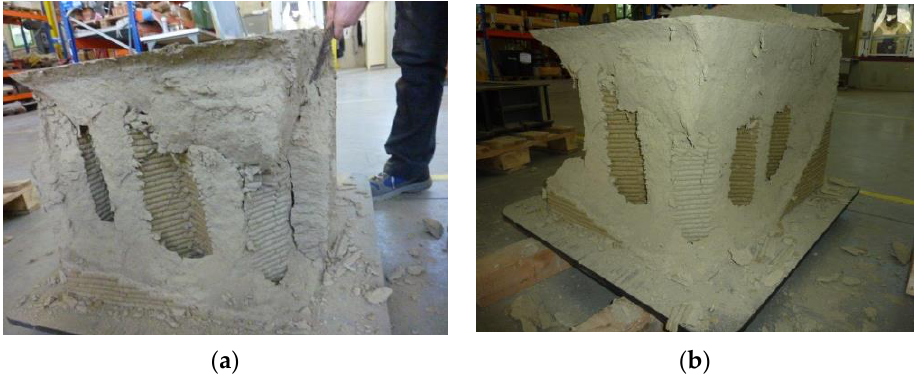
Figure 24. Side views of the specimen after the test: ( a ) before and ( b ) after the removal of the material isolated (only in part) by the sliding surfaces.